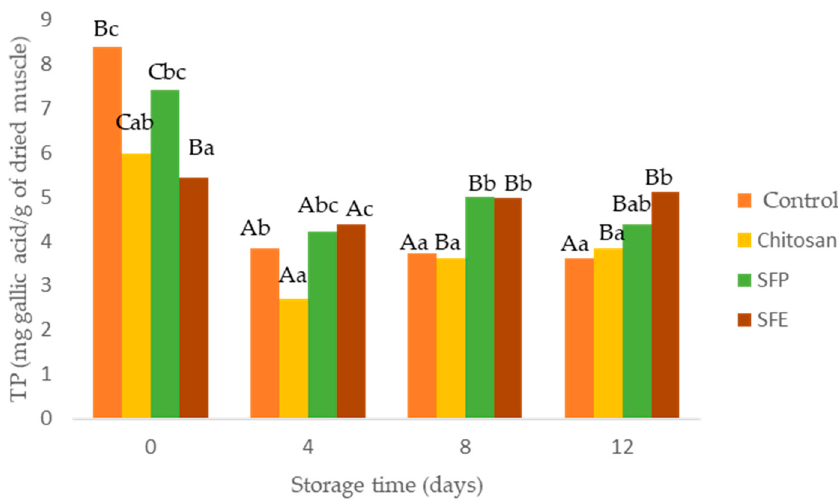
Figure 4. Total phenol content (TP) in Atlantic horse mackerel burgers coated with different film formulations (control without coating film, chitosan, sea fennel plant (SFP) incorporated in a chitosan-based film and sea fennel extract (SFE) incorporated in a chitosan-based film) and stored at 4 °C for 12 days. Different uppercase letters indicate significant differences ( p < 0.05) over storage time in each treatment. Different lowercase letters indicate significant differences ( p < 0.05) due to the treatment.